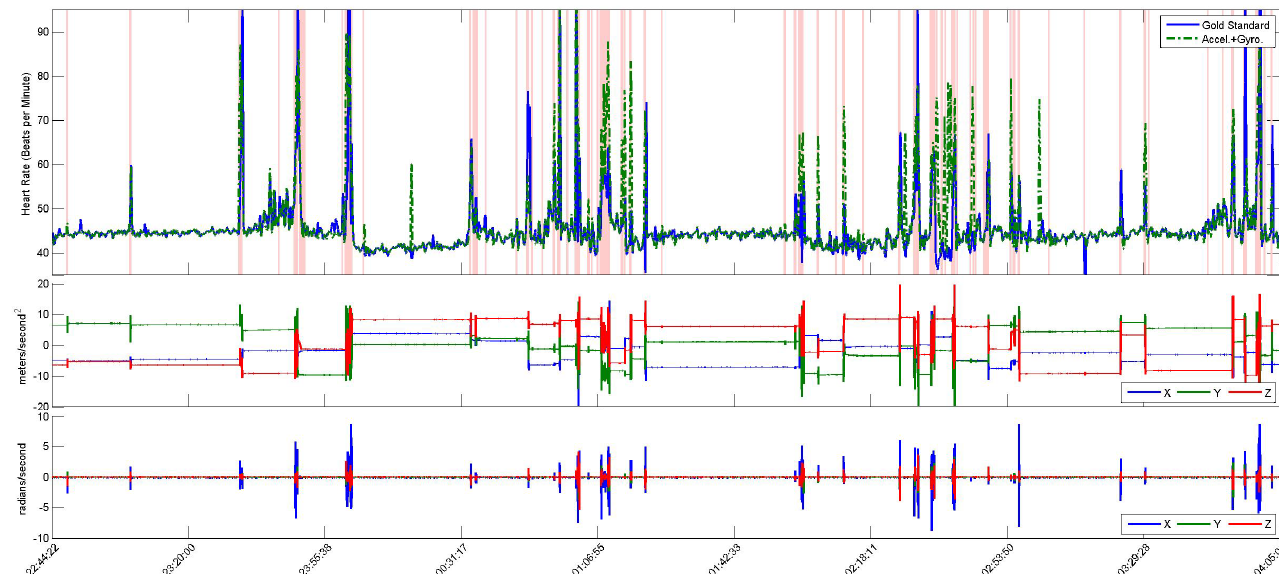
Fig. 7. Representative example of heart estimation with motion-based sensors on the wrist (dashed-green) and chest ECG electrodes (blue) during one night of sleep. Raw accelerometer (middle) and gyroscope (bottom) readings. Red areas in the top graph indicate regions with excessive accelerometer motion.